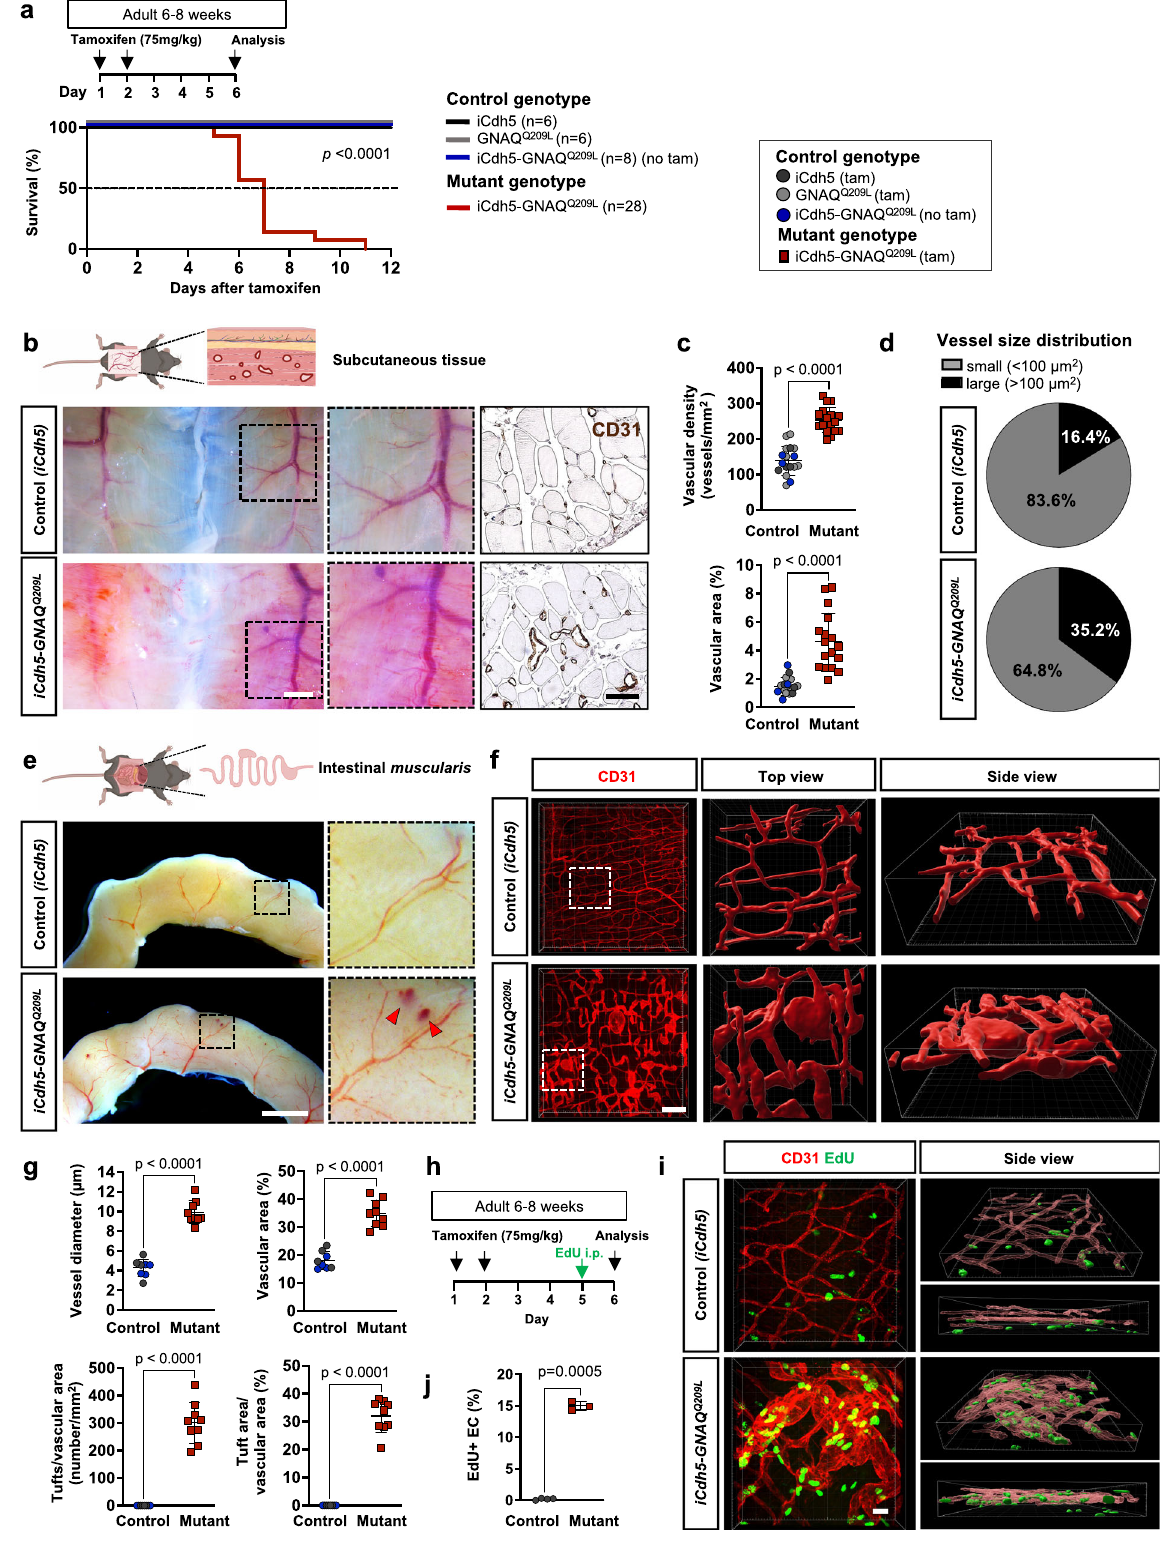
iCdh5-GNAQ Q209L mice showed thrombocytopenia (low number of pla- telets), with a 42.2% reduction in platelet number compared to control animals. Mutant mice were also anemic, with 35.9% lower red blood cell (RBC) count and 34.5% lower hemoglobin levels, compared to tamoxifen-treated littermates and mutant mice that did not receive tamoxifen (Fig. 4b, c and Supplementary Fig.